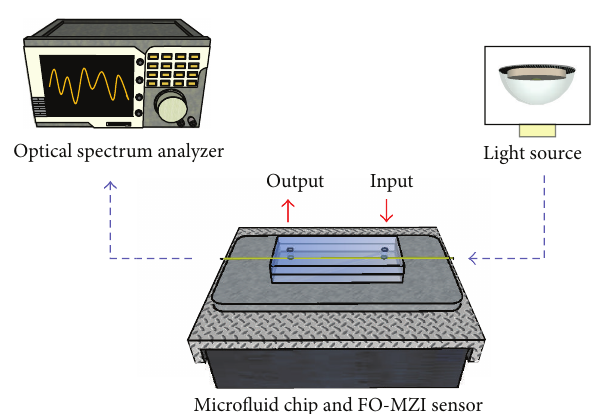
Figure 6: Schematic of refractive index detection using FO-MZI